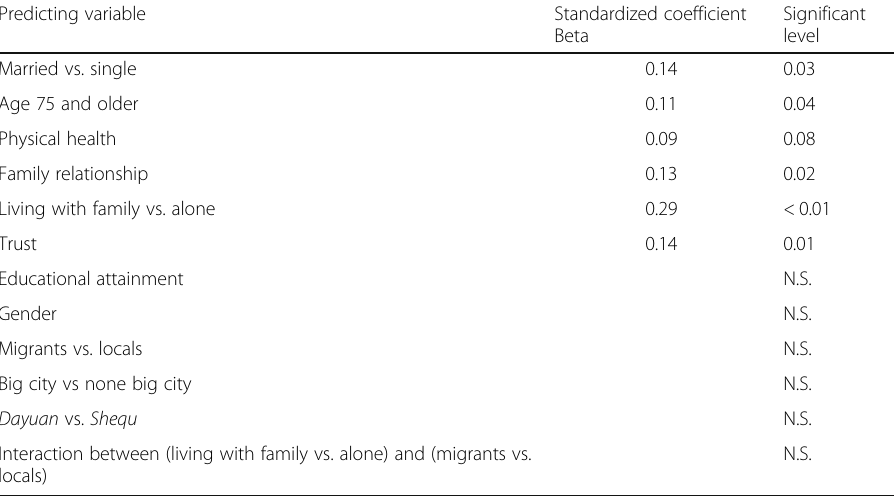
Table 4 Regression results: predicting variables, coefficients, and P values Predicting